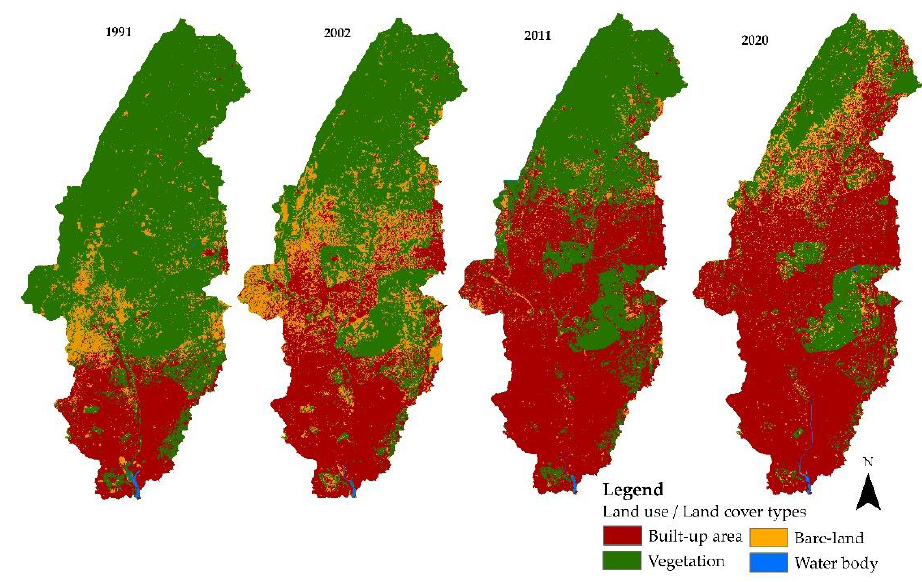
Figure 7. The results of the LULC change assessment in the Odaw River catchment from 1991 to 2020. Source: own LULC change assessment by the authors.